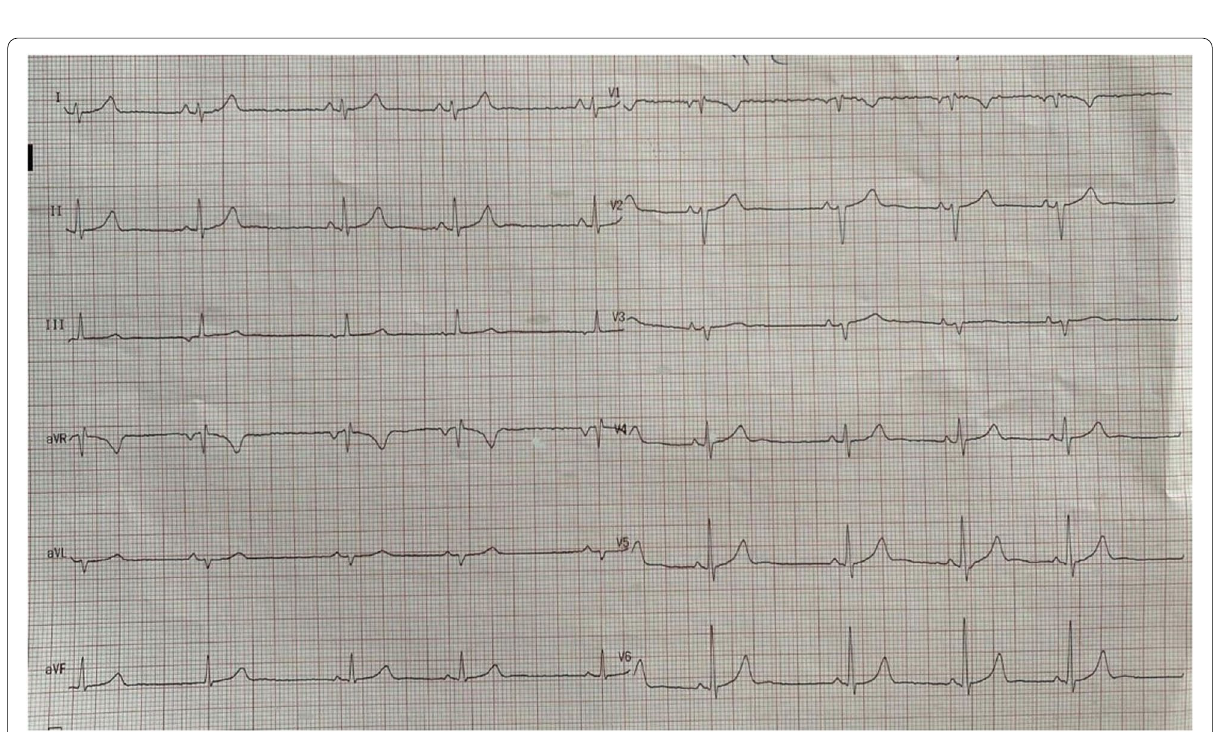
Fig. 2 Electrocardiogram displaying sinus bradycardia in the patient with hepatitis A while